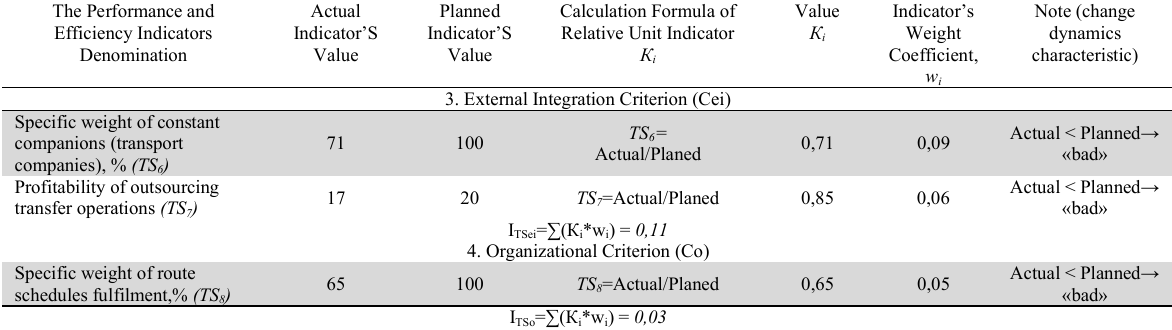
Determination of performance and efficiency indicators of transport supply business processes execution of a building production (TS) (Cont.)